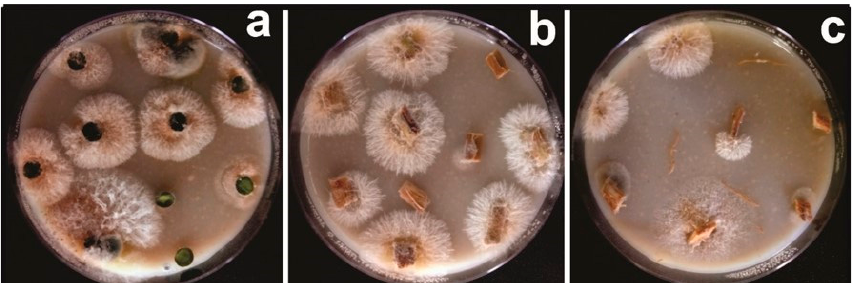
Figure 4. Examples of isolation of Clonostachys from coffee tissues inoculated with ( a ) C. rosea COAD 2985, from leaf samples; ( b ) C.rhizophaga COAD 2979, from stem samples; and ( c ) C.rhizophaga COAD 2979, from root samples.